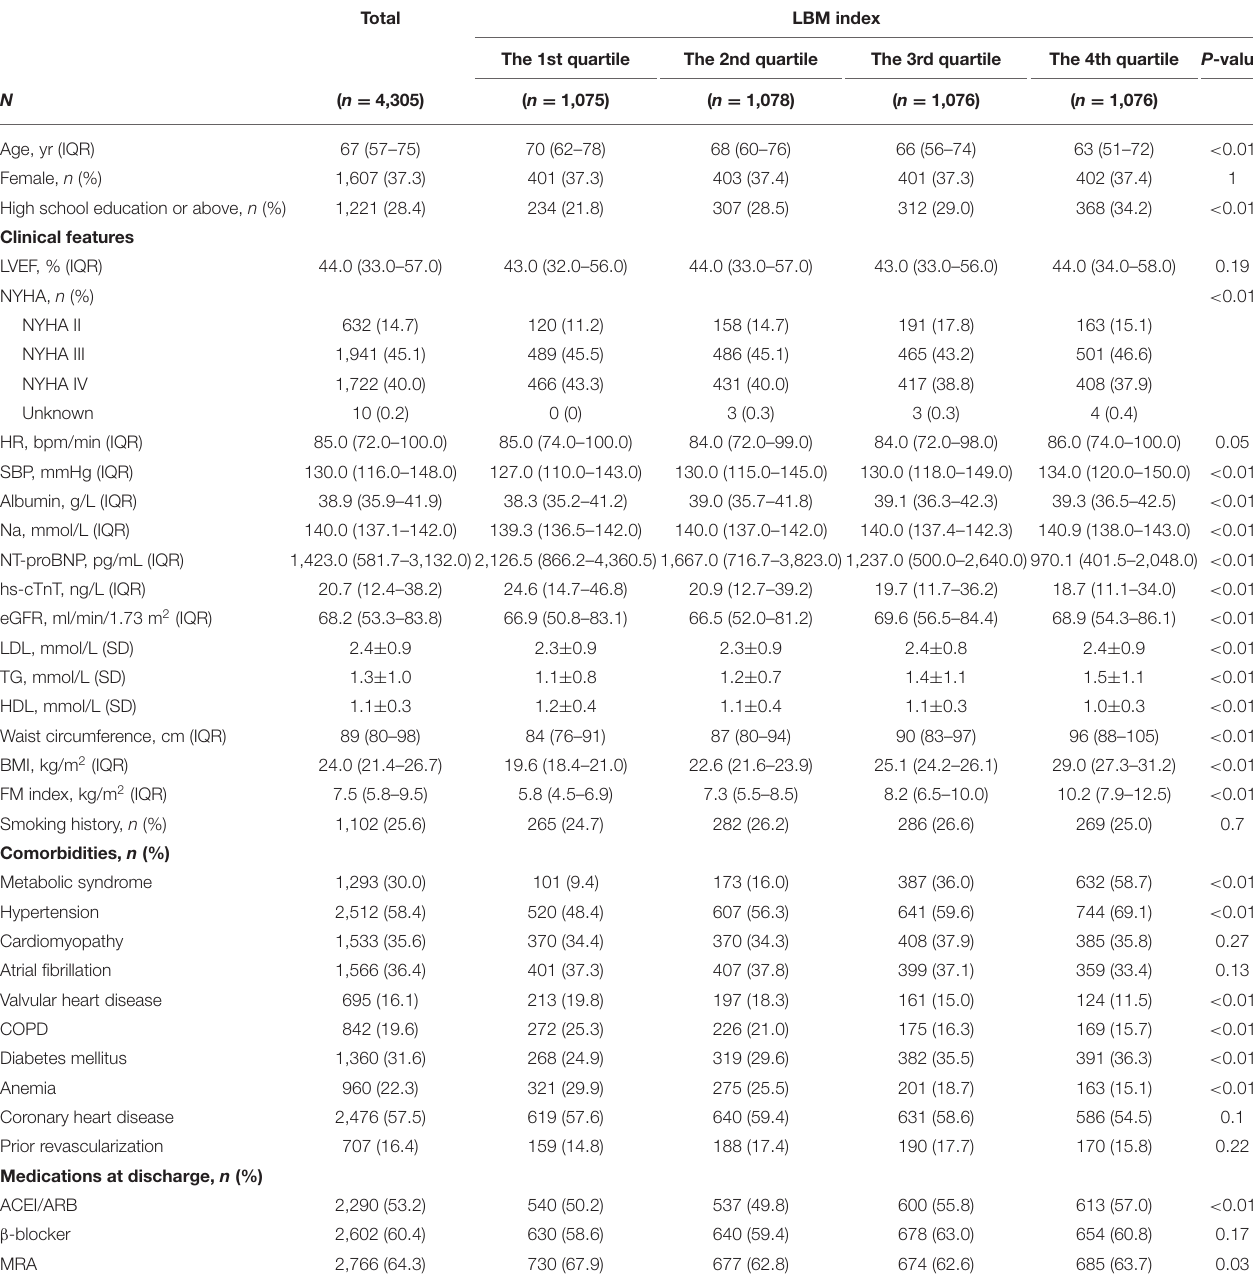
TABLE 1 | Baseline characteristics of patients hospitalized for HF among sex-adjusted lean body mass (LBM) index